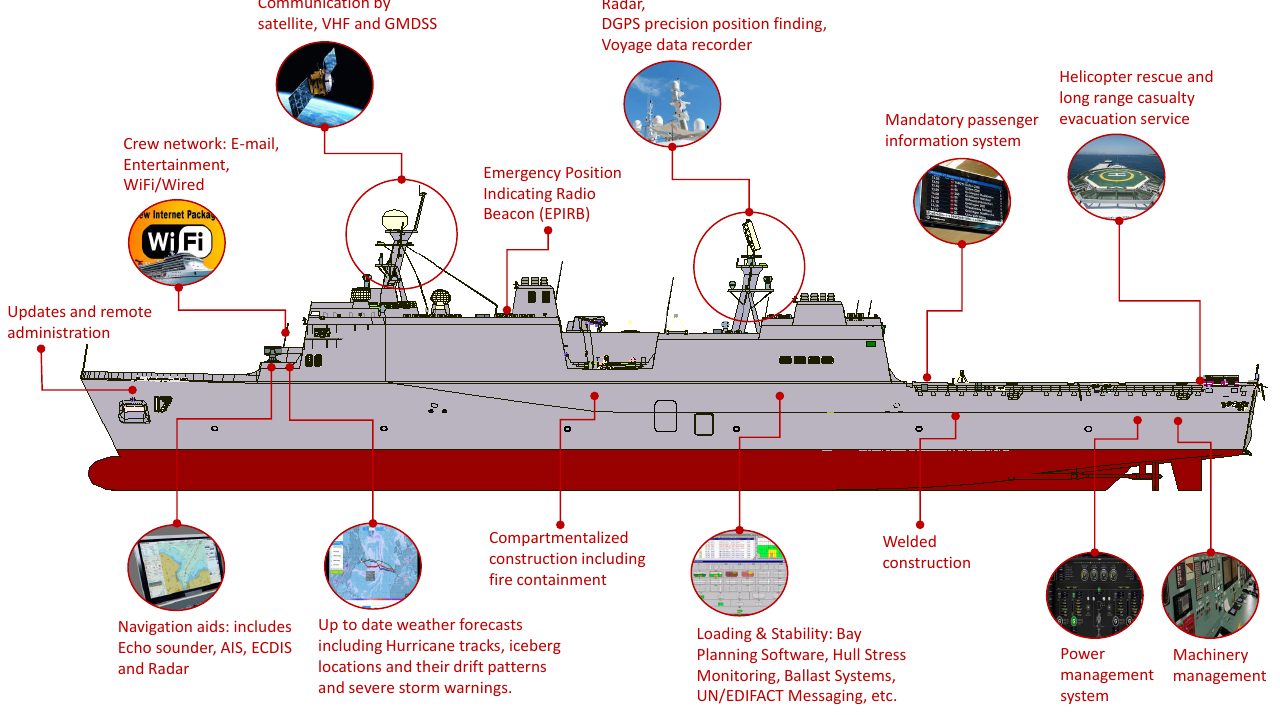
Figure 1. Automation systems for modern and autonomous ships [13]. Navigation systems include the Electronic Chart Display and Information System (ECDIS), the Global Positioning System (GPS), and the Global Navigation Satellite